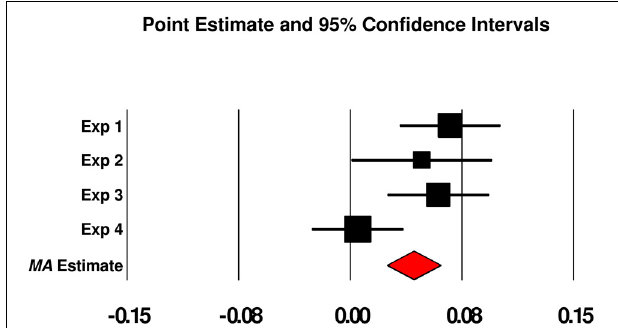
FIGURE 5 | Forest plot from a fixed-effect meta-analysis of the point estimate for the differences in mind wandering rates between personal-goal cued trials and other-goal cued trials across Experiments 1–4. Boxes represent the weighted point estimates for each experiment, error bars represent 95% confidence intervals, and the red diamond represents the meta-analytic point estimate across all experiments (with diamond width reflecting the 95% confidence interval). Note: Exp 1, Experiment 1; Exp 2, Experiment 2; Exp 3, Experiment 3; Exp 4, Experiment 4; MA estimate, meta-analytic point estimate.